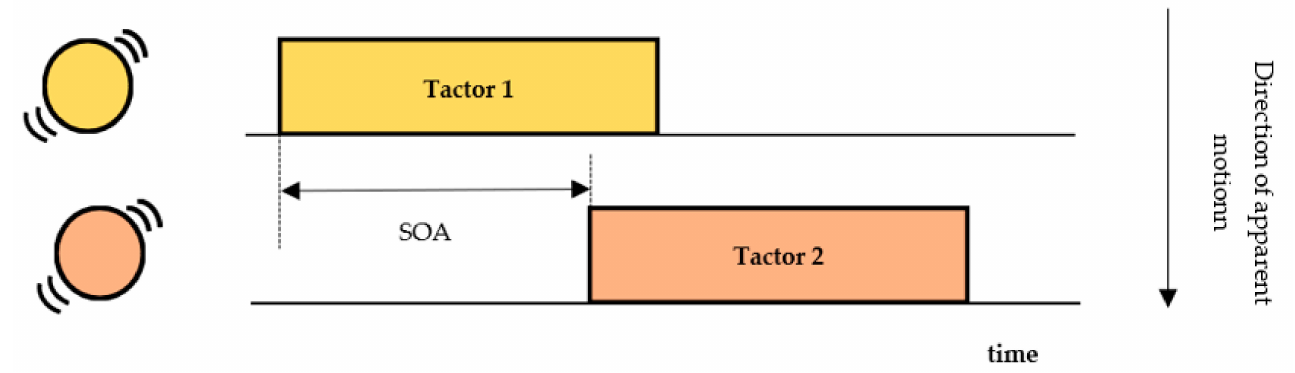
Figure 4. The illusion of